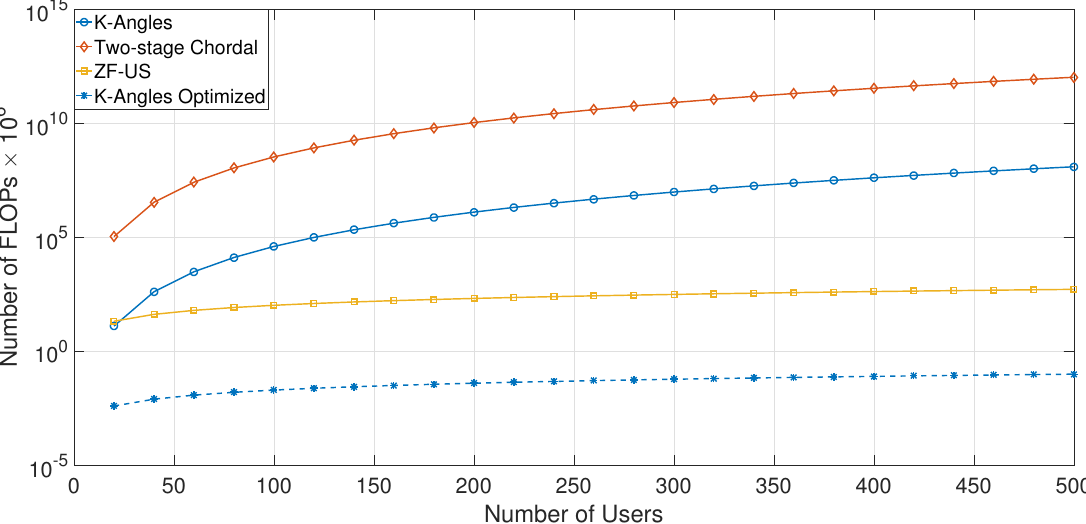
Figure 6. User clustering complexity for various distance metrics and grouping algorithms. US, User